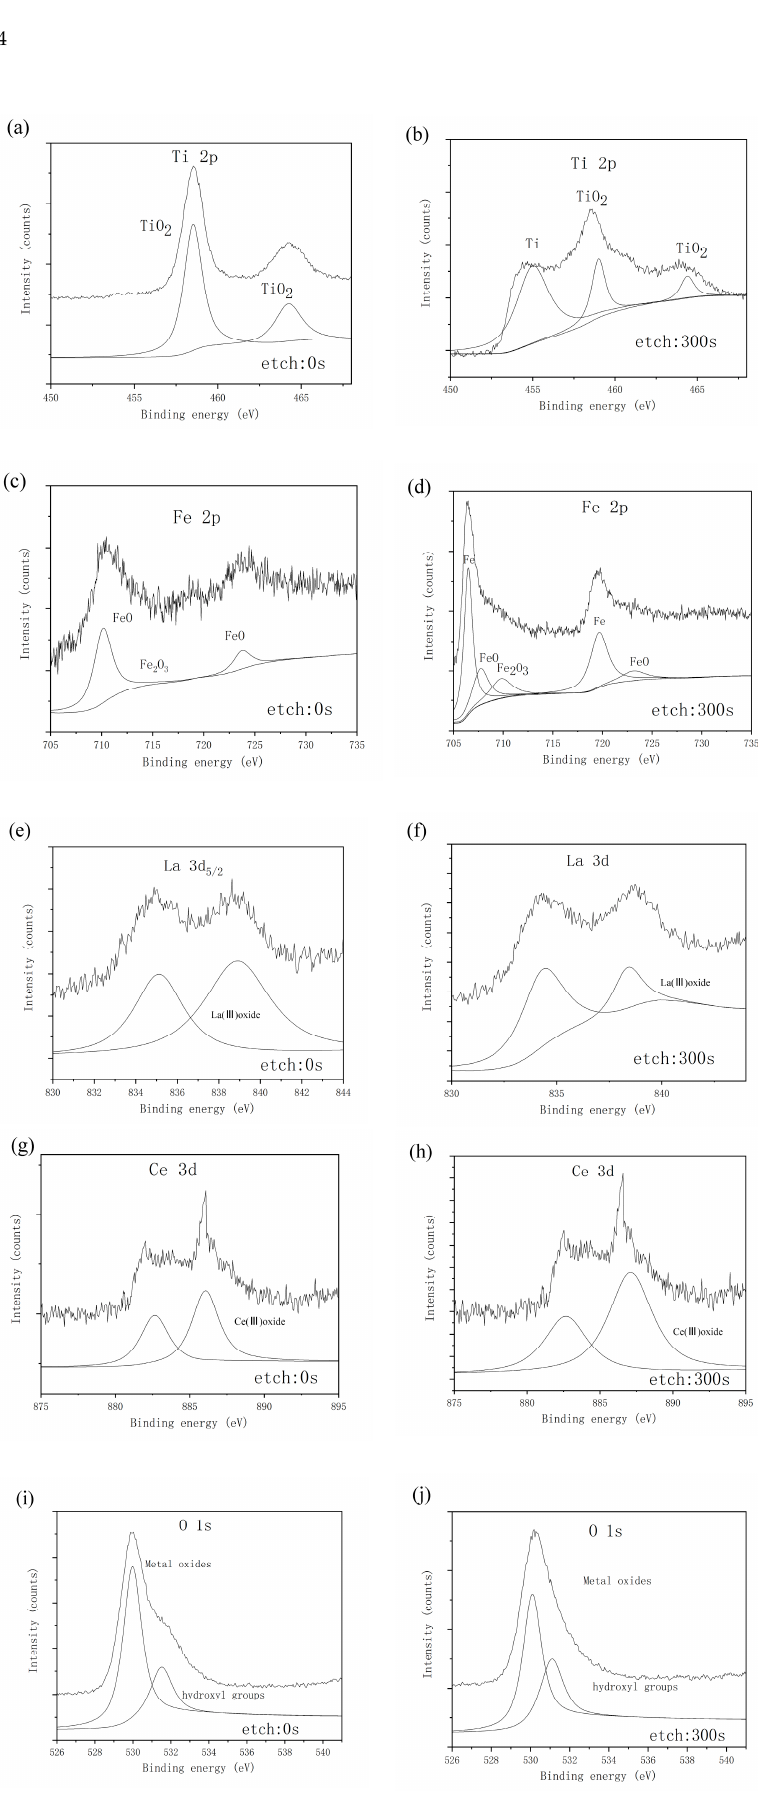
Figure9. Ti 2p ( a , b ); Fe 2p ( c , d ); La 3d ( e , f ); Ce 3d ( g , h ); and O 1s ( i , j ) XP spectrumof TiFe 0.86 Mn 0.07 Co 0.07 + 4% Mm after 40 cycles in H 2 containing 250 ppm O 2